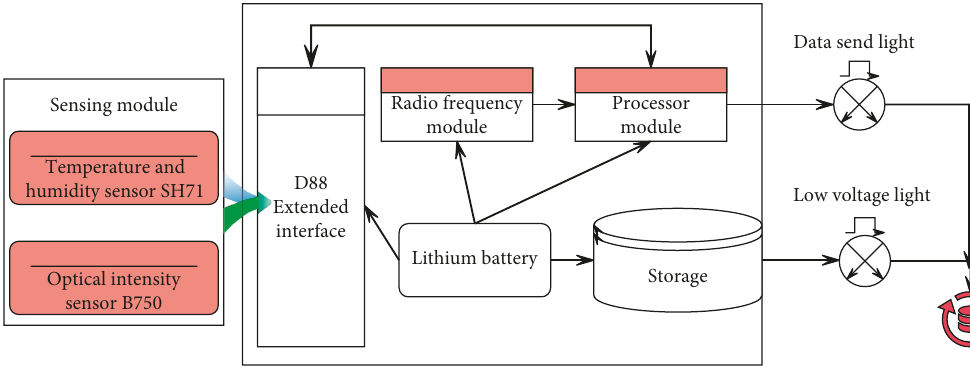
Figure 7: Wireless sensor node.